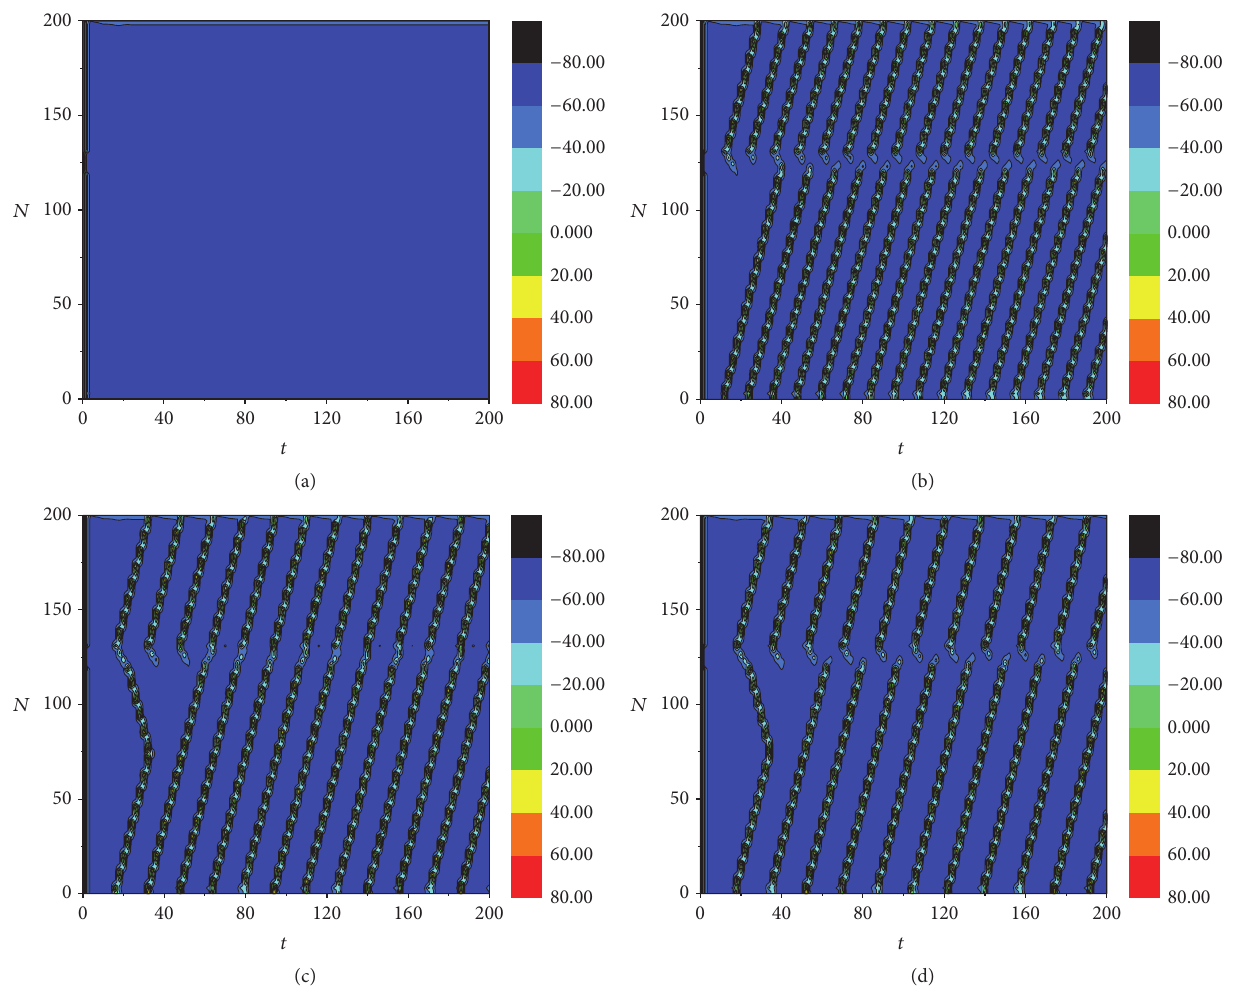
Figure 2: Wave propagation along axon when autapse is developed from node 𝑖 = 3,131 : external forcing is applied on node 𝑖 = 3 ; for time delays (a) 𝜏 = 2 , (b) 𝜏 = 10 , (c) 𝜏 = 14 , and (d) 𝜏 = 16 , the feedback gain in electric autapse is set as 𝑔 𝑒 = 1.5 and external forcing 𝐼 ext = 20 is imposed on node 𝑖 = 3 . The injured area generated by decreasing the conductance of sodium from 𝐺 Na = 120 mS/cm 2 to 𝐺 Na = 25.5 mS/cm 2 : the axon is divided into 201 nodes and the injured area is marked from nodes 𝑖 = 120 to 130 . The snapshots are illustrated in color